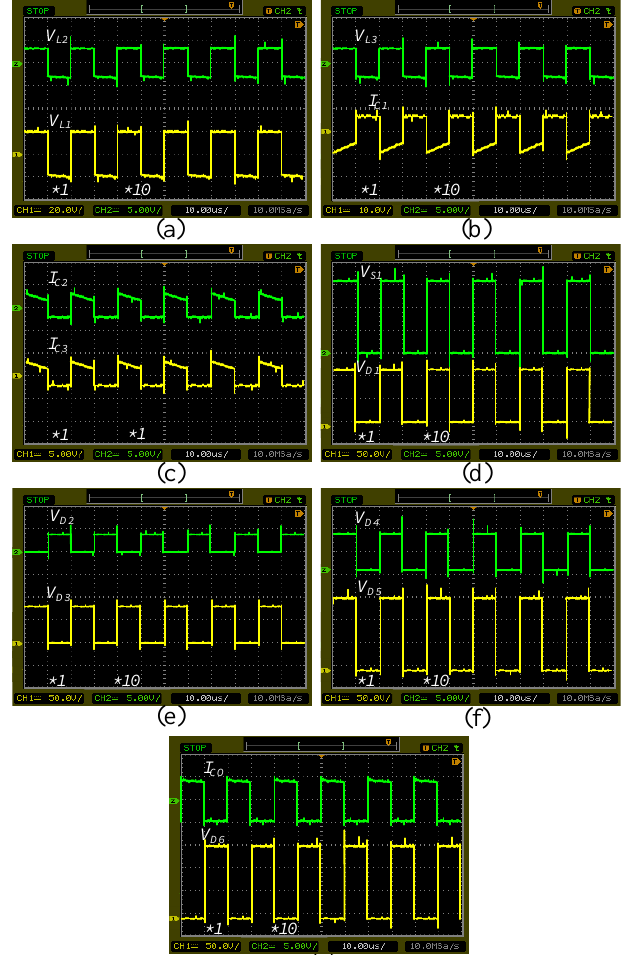
Figure 18. The experimental outcomes: ( a ) the first and second inductors’ voltage, ( b ) the third inductor’s voltage and first capacitor current, ( c ) second and third capacitors’ current, ( d ) switch and first diode’s voltage, ( e ) second and third diodes’ voltage, ( f ) fourth and fifth diodes’ voltage, ( g ) last capacitor’s current and sixth diode’s voltage.